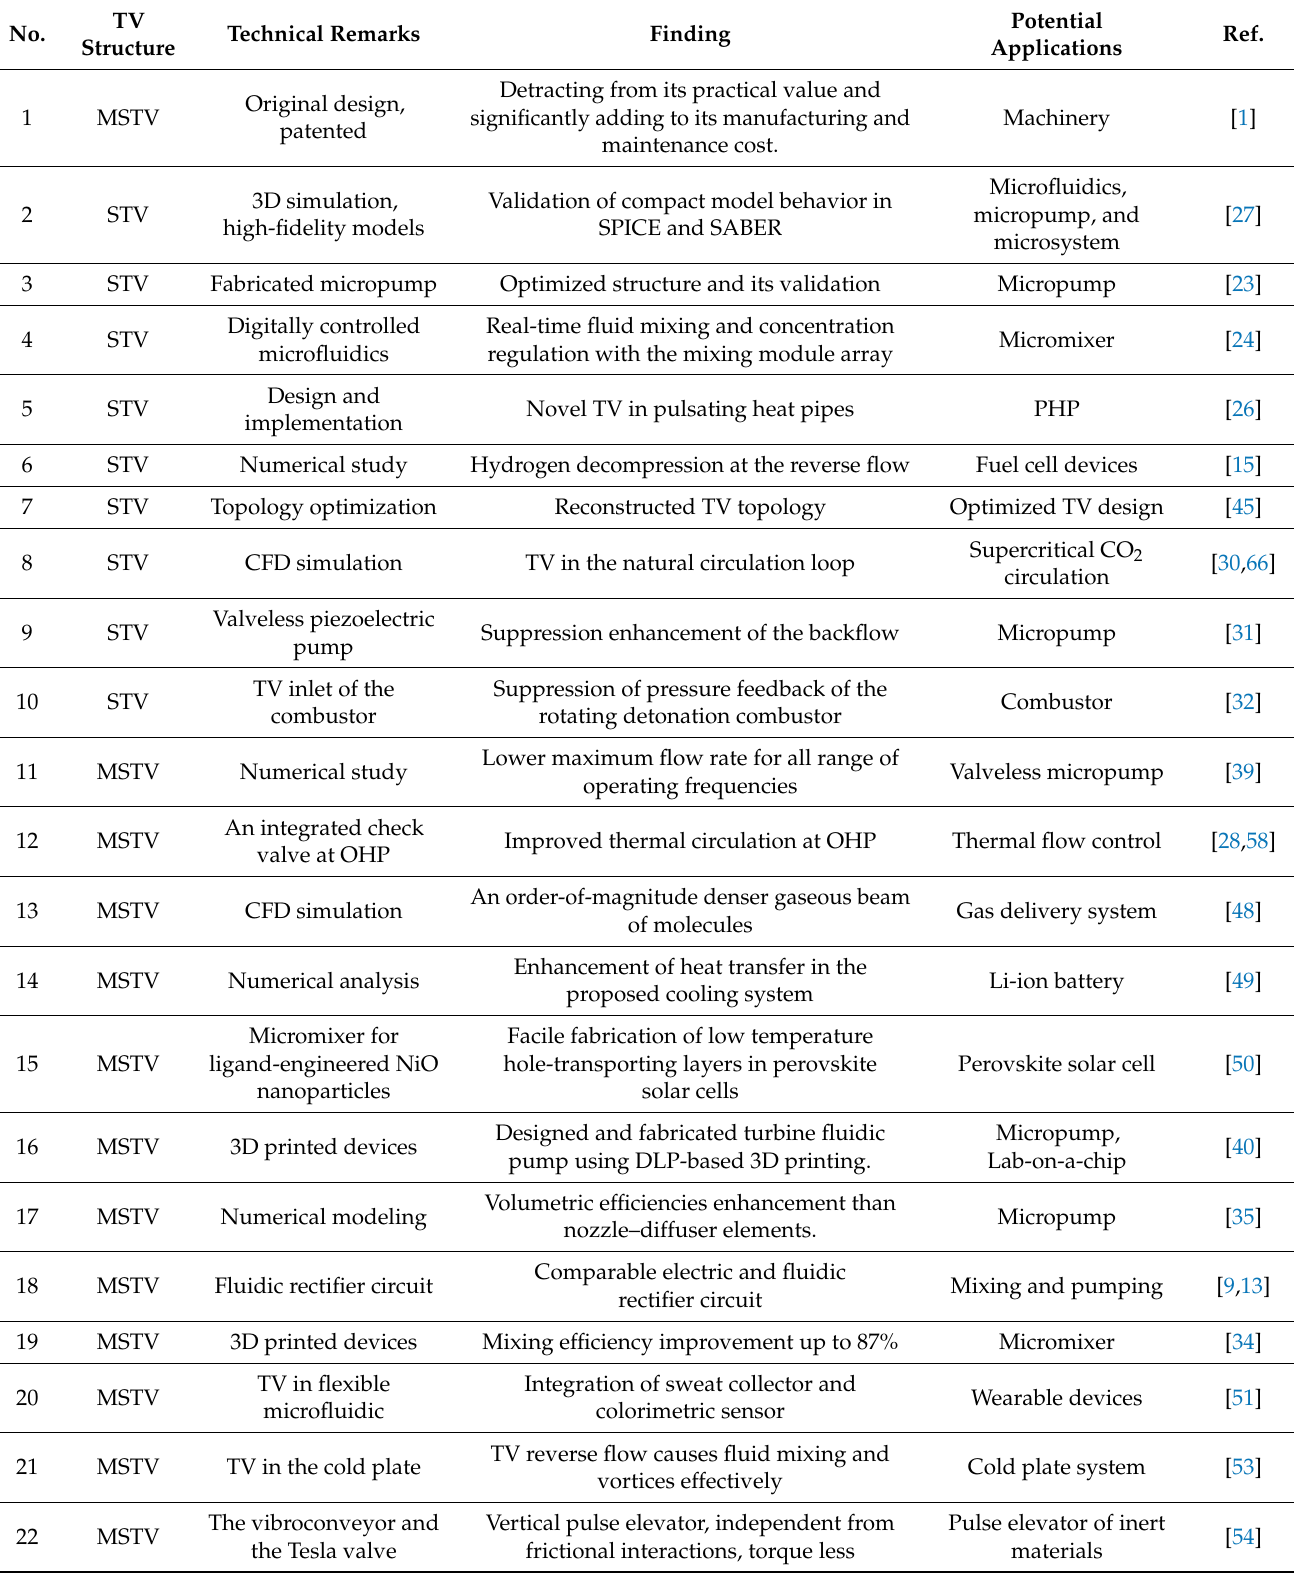
Table 1. The list of TV fluidics report, with its findings and potential